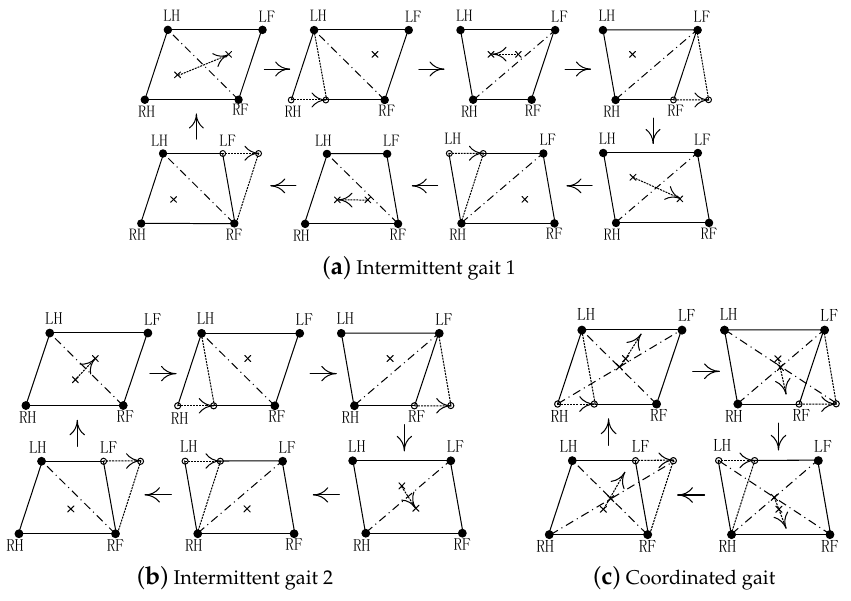
Figure 4. Three typical stability-guaranteed static